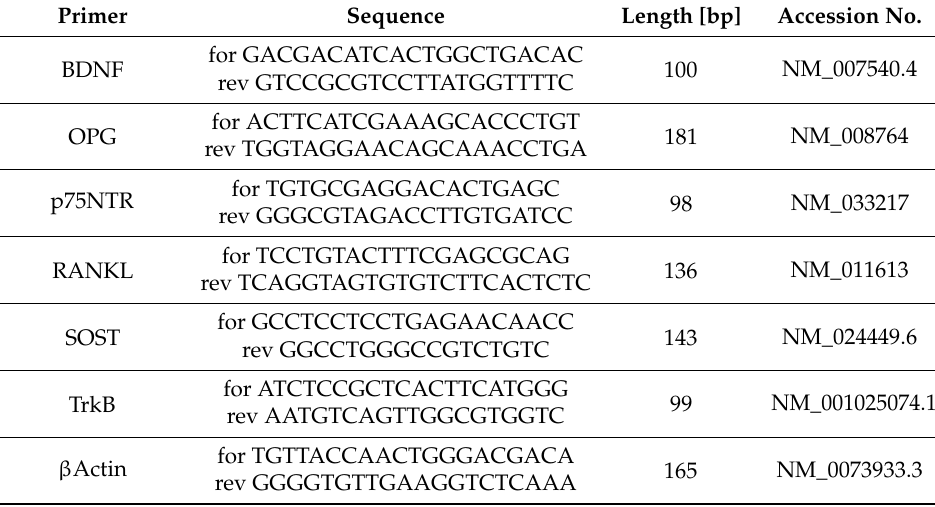
Table 1. Mouse primers used for real-time RT-PCR